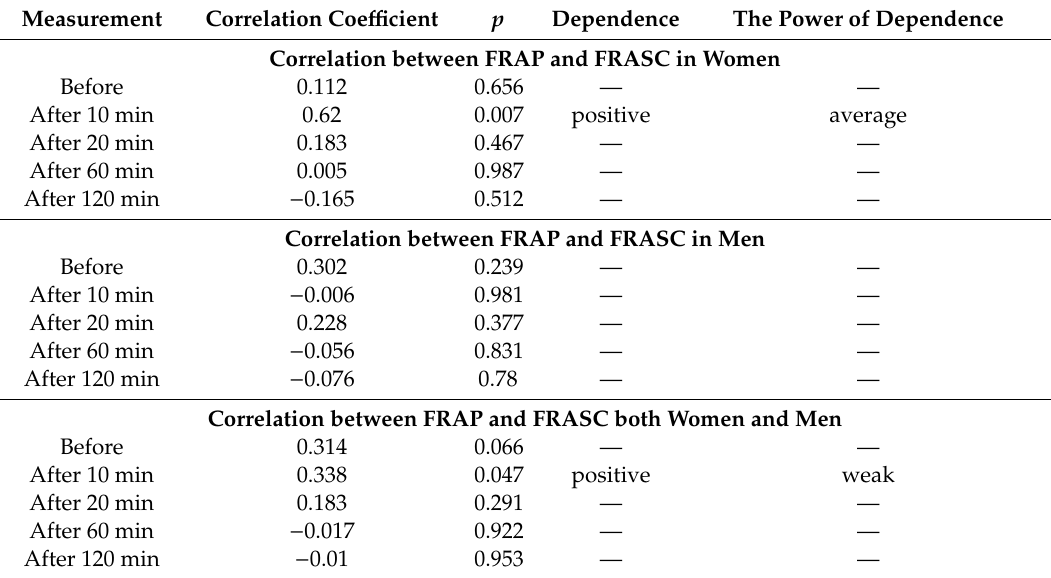
Table 4. Correlation between FRAP and FRASC values in patients undergoing routine HRCT before the test, 10, 20, 60 and 120 min after the test.